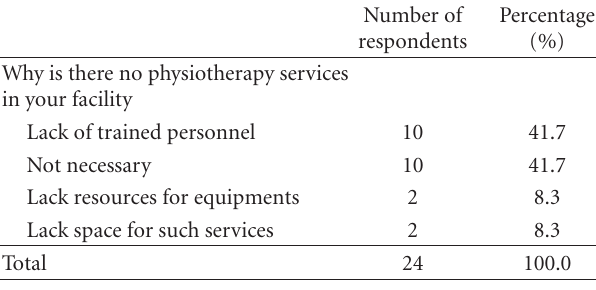
Table 5: Reasons for lack of physiotherapy services in the 24 health facilities in the study area.